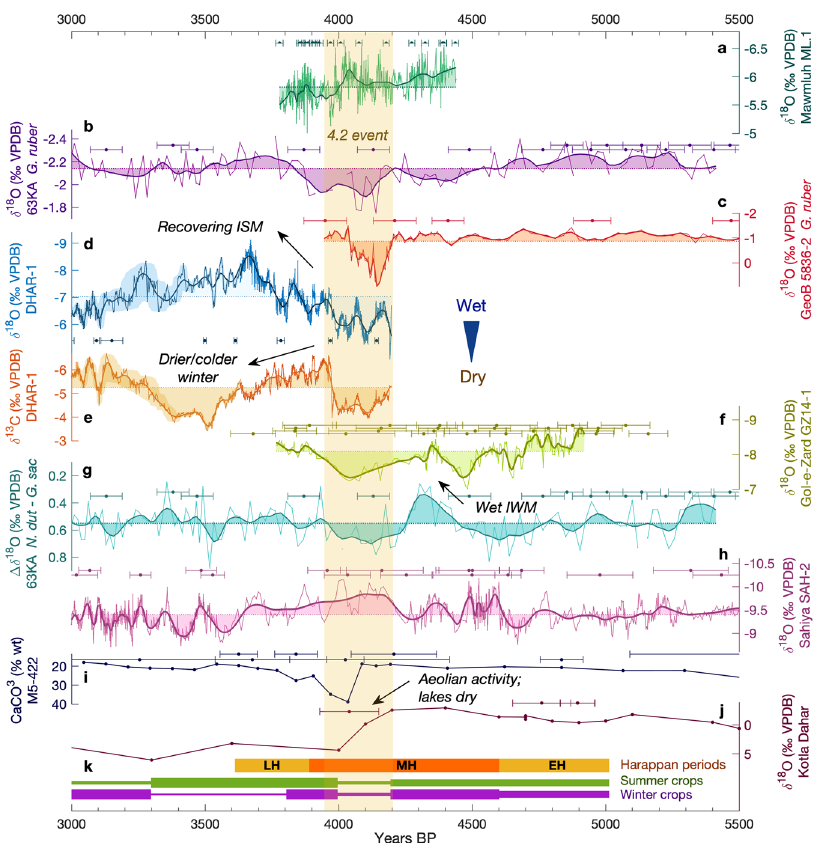
Fig. 4 Comparison of northwest South Asian records over the 4.2 ka event. a Indian Mawmluh stalagmite ML.1 δ 18 O 27 , b Arabian Sea marine core 63KA δ 18 O of G. ruber 400 – 500 μ m 69 , c Red Sea marine core GeoB 5836-2 δ 18 O of G. ruber 70 , d Indian stalagmite DHAR-1 δ 18 O (this study), e DHAR-1 δ 13 C (this study), f Iranian Gol-e-Zard stalagmite GZ-14-1 δ 18 O 23 , g marine core 63KA Δδ 18 O of N. dutertrei — G. sacculifer 69 , h Indian Sahiya stalagmite SAH-2 δ 18 O 28 , i Gulf of Oman marine core M5-422 CaCO 3 71 , j Kotla Dahar lake δ 18 O 19 , and k Early Harappan (EH, c. 5.0 – 4.6 ka BP), Mature Harappan (MH, c. 4.6 – 3.9 ka BP), and Late Harappan (LH, c. 3.9 – 3.6 ka BP) periods, shown with interpreted favorability for summer and winter crop cultivation based on the climate records in the fi gure. Dates are shown above each record with ±2 σ error